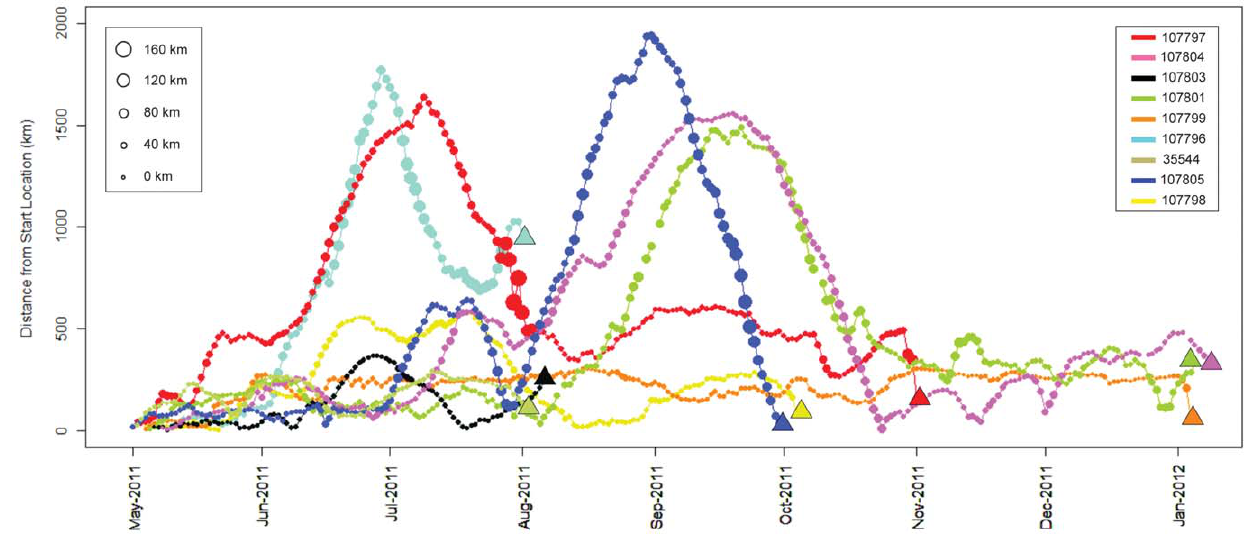
Figure 5. Chart showing distance from start location (km) by date for nine oceanic whitetip sharks equipped with Standard Rate tags. Circles of varying size indicate distance traveled (km; five-day central moving average) during periods of the track. Triangles represent distance from tagging site to pop-up location. Colors correspond to tag ID.